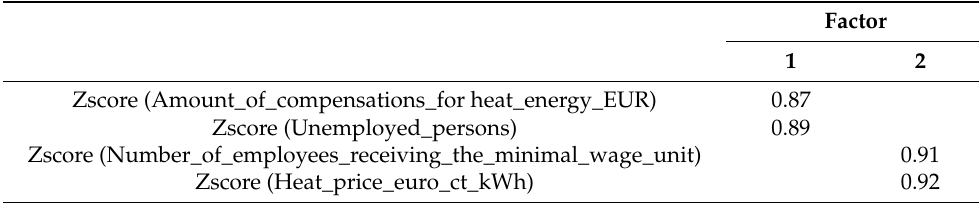
Table 6. Factor rotation analysis for shadow economy risk indicators.